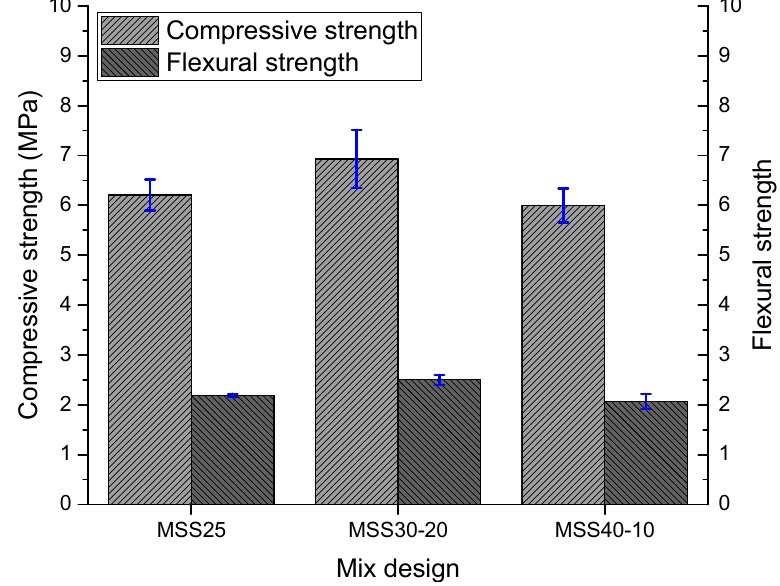
Figure 8. Results of compressive and flexural strength tests.